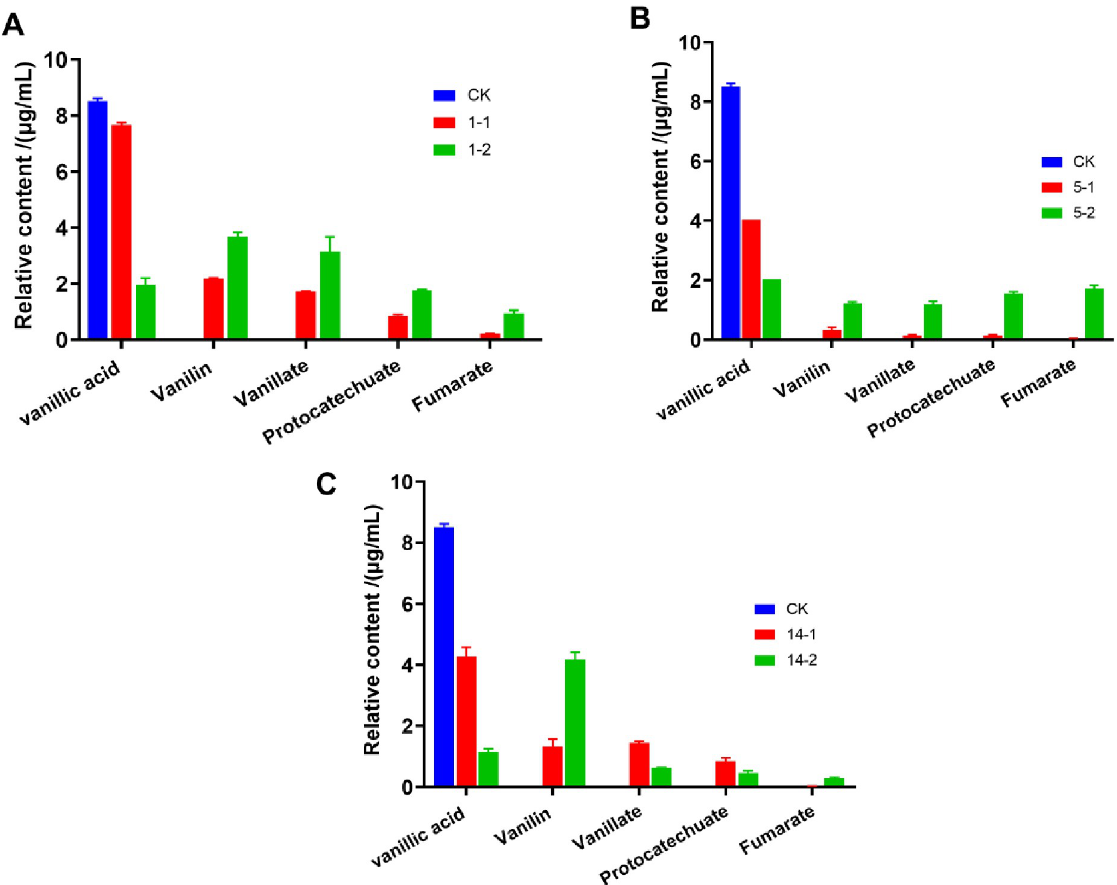
Fig 7. Growth of ZXY12VA01 (A), ZXY12VA05 (B) and ZXY12VA14 (C) on vanillic acid. The four major metabolites were detected on the 12h and 24h, respectively.